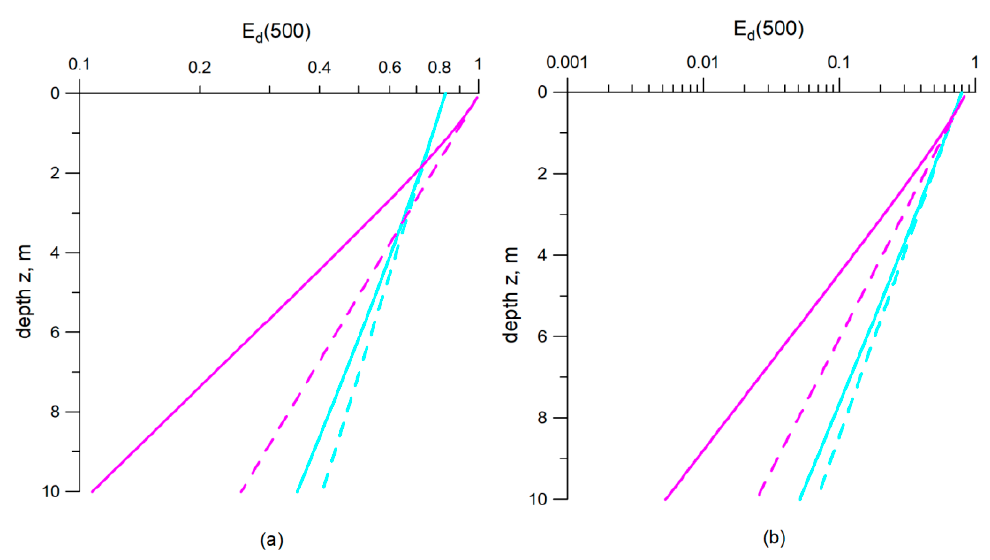
Table 6. The value of < K > (500) m − 1 for the cases of the Black Sea and Barents Sea, depending on the value of N coc , illumination conditions, and the absorption coefficient.